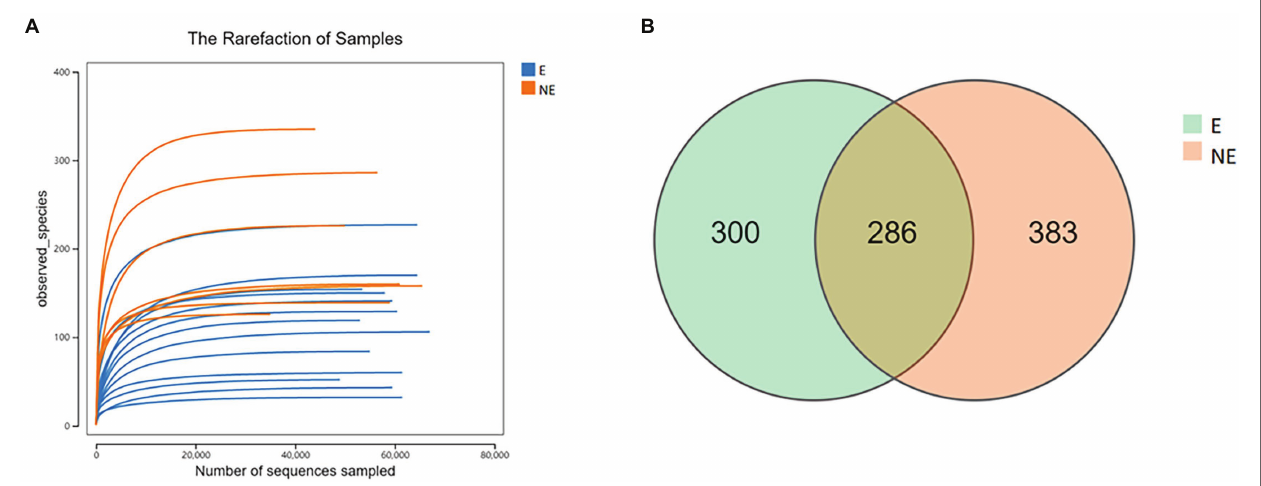
FIGURE 1 | (A) Rarefaction curve. Curves of different colors show the observed species ( Y -axis) of each sample at different number of sequences sampled ( X -axis). When the curve tended to be flat, the amount of the sequenced data was large enough to reflect the majority of the microbial data in the samples. (B) OTU distribution in the two groups. The green and orange circles represented samples of vaginal secretions in the E and the NE group, respectively. The overlap denoted the OTUs shared by two